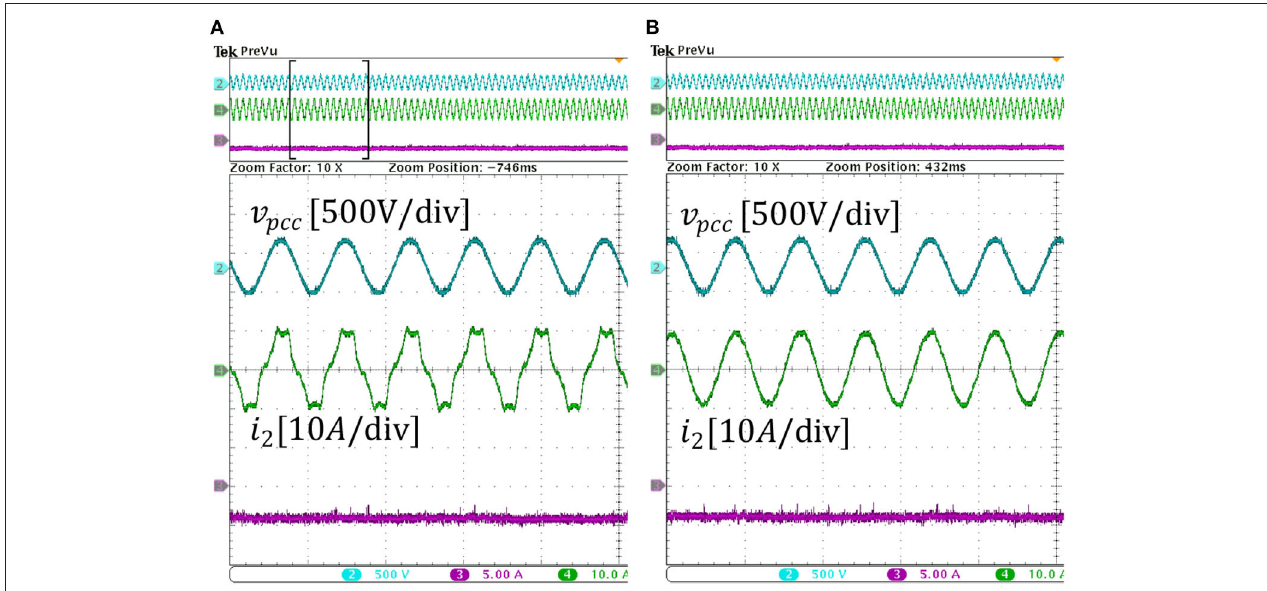
FIGURE 14 | Converter output current: (A) without harmonic suppression, (B) with harmonic current suppression using converter-side current feedback.